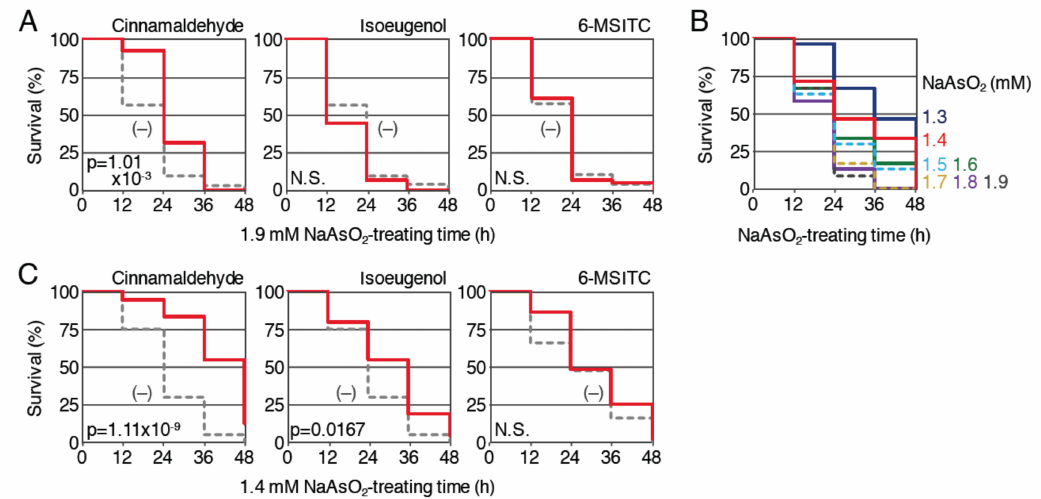
Figure 5. E ff ects of pretreatment with phytochemicals on the survival rates of Nrf2-homozygous mutant larvae exposed to NaAsO 2 . ( A ) Survival assays using Nrf2-mutant larvae prepared from homozygous mutant parents. Larvae (3.5 dpf) were pretreated with (red; 50 µ M cinnamaldehyde, 25 µ M isoeugenol or 10 µ M 6-MSITC) or without (gray, dotted) indicated phytochemicals. After pretreatment for 12 h, the solution was changed to 1.9 mM NaAsO 2 and survival was measured every 12 h for 48 h. ( B ) Determination of the optimal NaAsO 2 concentrations for survival analyses using Nrf2-mutant larvae. Larvae (4 dpf) were exposed to NaAsO 2 at concentrations of 1.3 to 1.9 mM for 48 h (1.3 (dark blue), 1.4 (red), 1.5 (light blue, dotted), 1.6 (green), 1.7 (yellow, dotted), 1.8 (purple), 1.9 mM (dark gray, dotted)). Survival rates were observed every 12 h. ( C ) Survival assays using a lower dose of NaAsO 2 . Larvae (3.5 dpf) of Nrf2 mutant were pretreated with (red; 50 µ M cinnamaldehyde, 25 µ M isoeugenol or 10 µ M 6-MSITC) or without (gray, dotted) indicated phytochemicals. After pretreatment for 12 h, the solution was changed to 1.4 mM NaAsO 2 and survival was measured every 12 h for 48